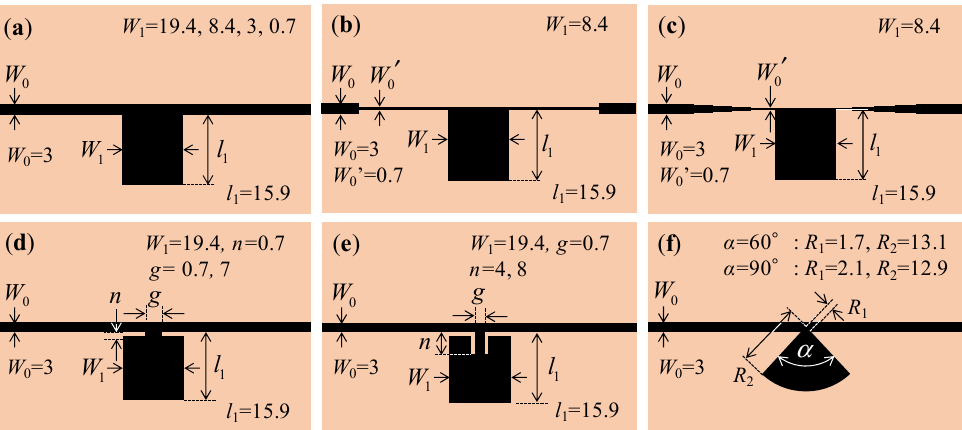
Figure 5. Schematic view of measurement samples examined in this study. All numerical units are in mm. ( a ) Rectangular stubs of four different characteristic impedance ratios Z 1 / Z 0 = 1/4, 1/2, 1, and 2. ( b ) Rectangular stub of Z 1 / Z 0 = 1/4, with no matching section except for the either end of the I/O line. ( c ) Rectangular stub of Z 1 / Z 0 = 1/4 with a tapered line. ( d ) Rectangular stubs of Z 1 / Z 0 = 1/4 with two different series inductances. ( e ) Rectangular stubs of Z 1 / Z 0 = 1/4 with a larger series inductance. ( f ) Radial stubs of central angle α = 60° and 90°.